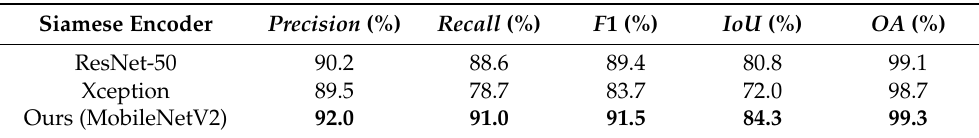
Figure 6. Illustrations of BuCD results on the WHUCD dataset using different backbones in the Siamese encoder. Six pairs of bitemporal images are shown from ( a – f ). White represents the cor- rectly identified changing buildings. Additionally, red and green denote the false and missed pre- dictions of changed buildings, respectively. Table 4. Quantitative analysis of LightCDNet with different settings in the Siamese encoder on the WHUCD dataset. The highest numbers are in bold.